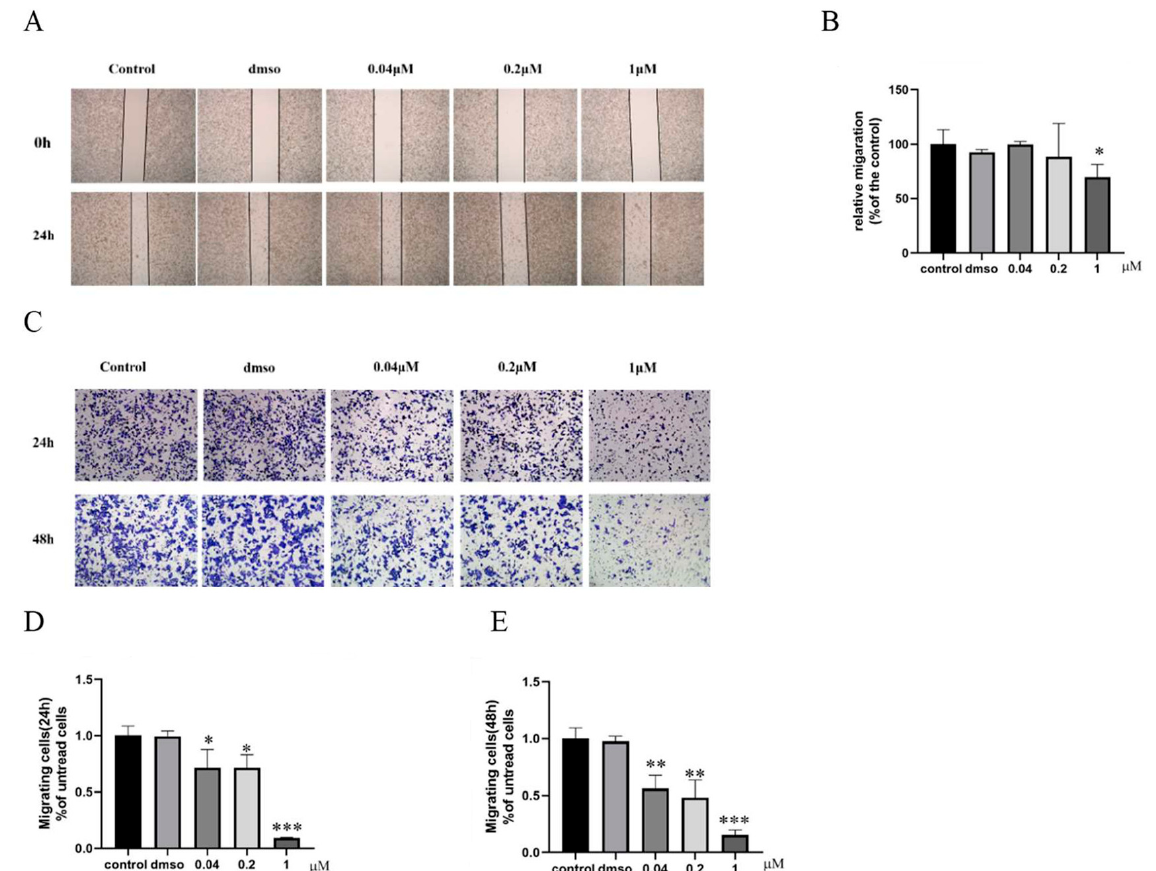
Figure 2. CHJ04022R inhibited the migration of A375 cells ( A , B ). The effect and statistical analysis of wound healing in A375 cells treated with indicated concentrations of CHJ04022R for 24 h in wound healing assay ( C – E ). The effect and statistical analysis of migration in A375 cells treated with CHJ04022R for 24 h and 48 h in transwell assay. Three independent experiments were performed. All data were expressed as the mean ± SD. * p < 0.05, ** p < 0.01, *** p < 0.001 compared to the control